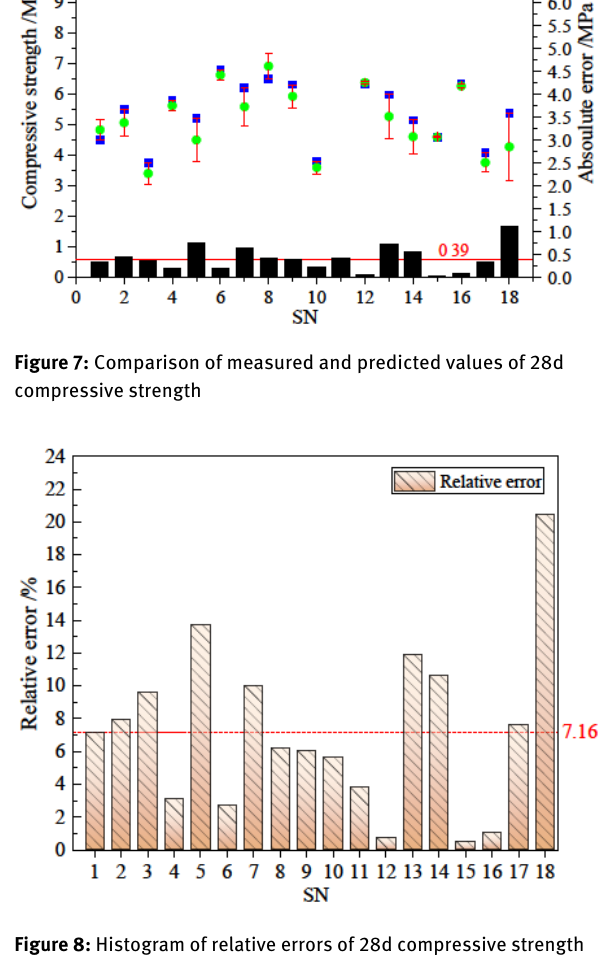
strength was in good agreement with the predicted value, indicating that the prediction effect was